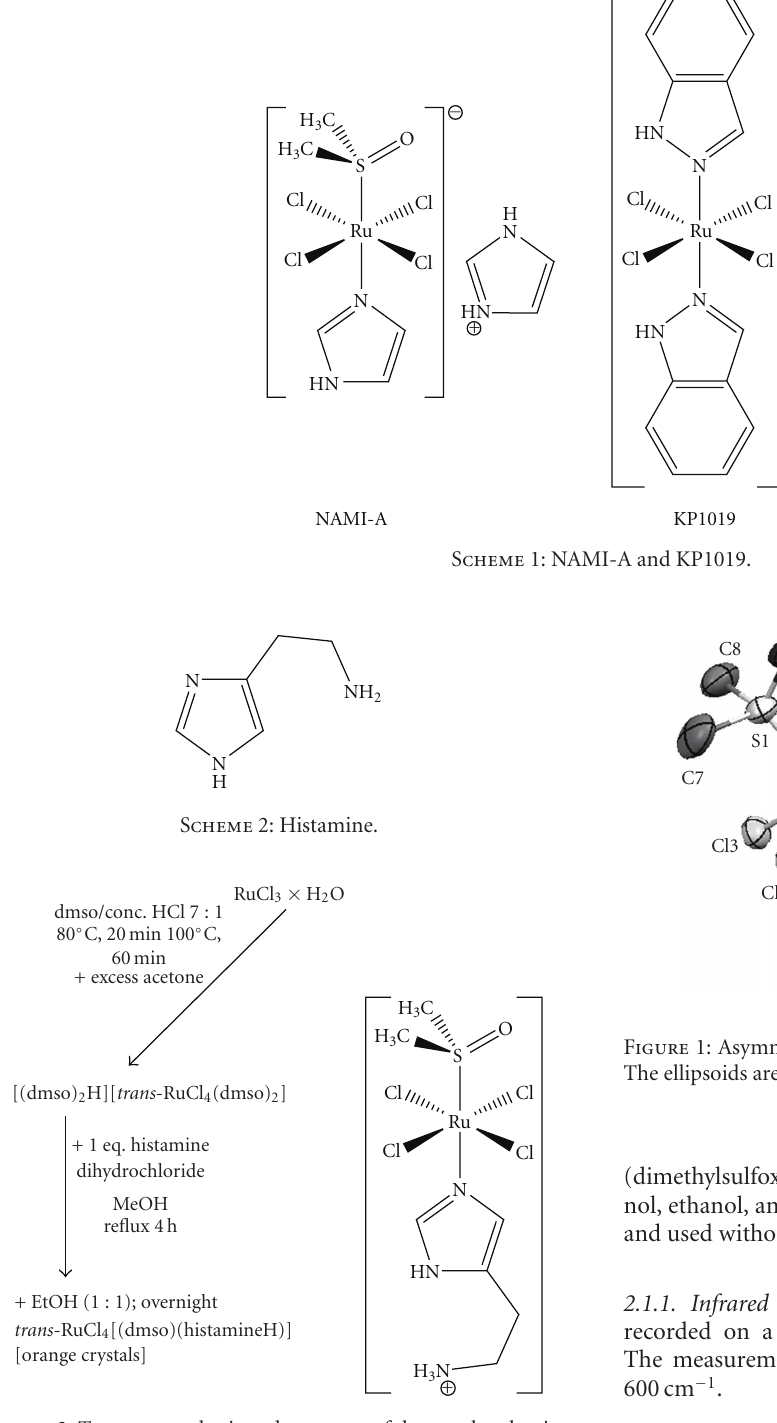
Scheme 3: Two step synthesis and structure of the novel ruthenium complex with histamine.